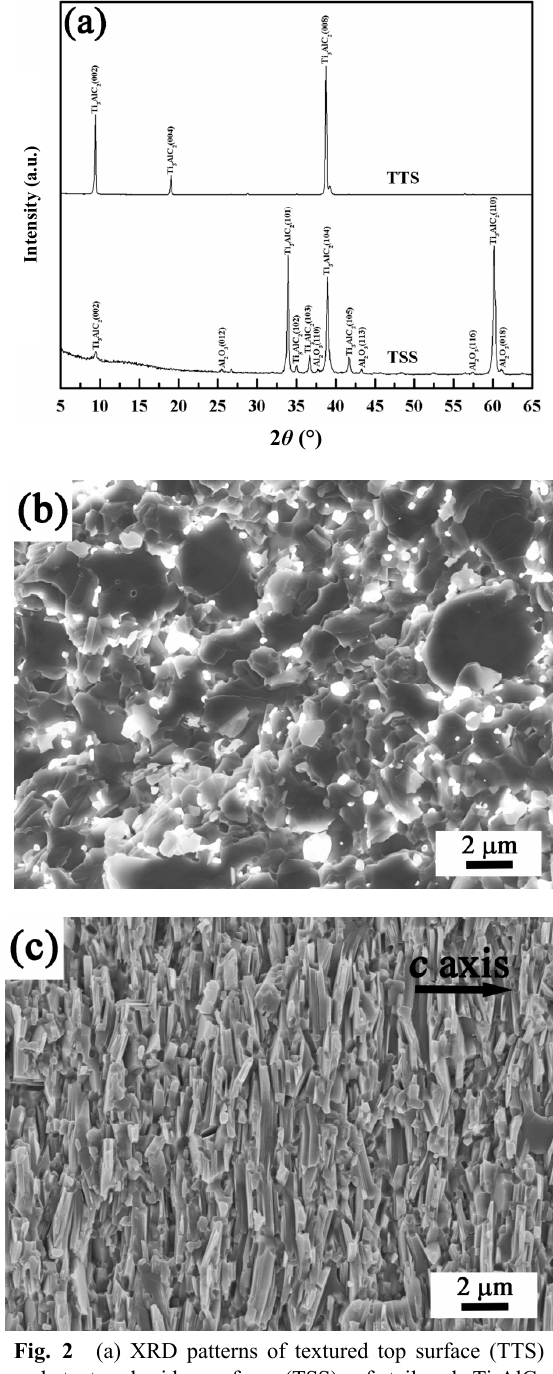
Fig. 2 (a) XRD patterns of textured top surface (TTS) and textured side surface (TSS) of tailored Ti 3 AlC 2 ceramic, and SEM micrographs of fracture surfaces of (b) TTS and (c) TSS.